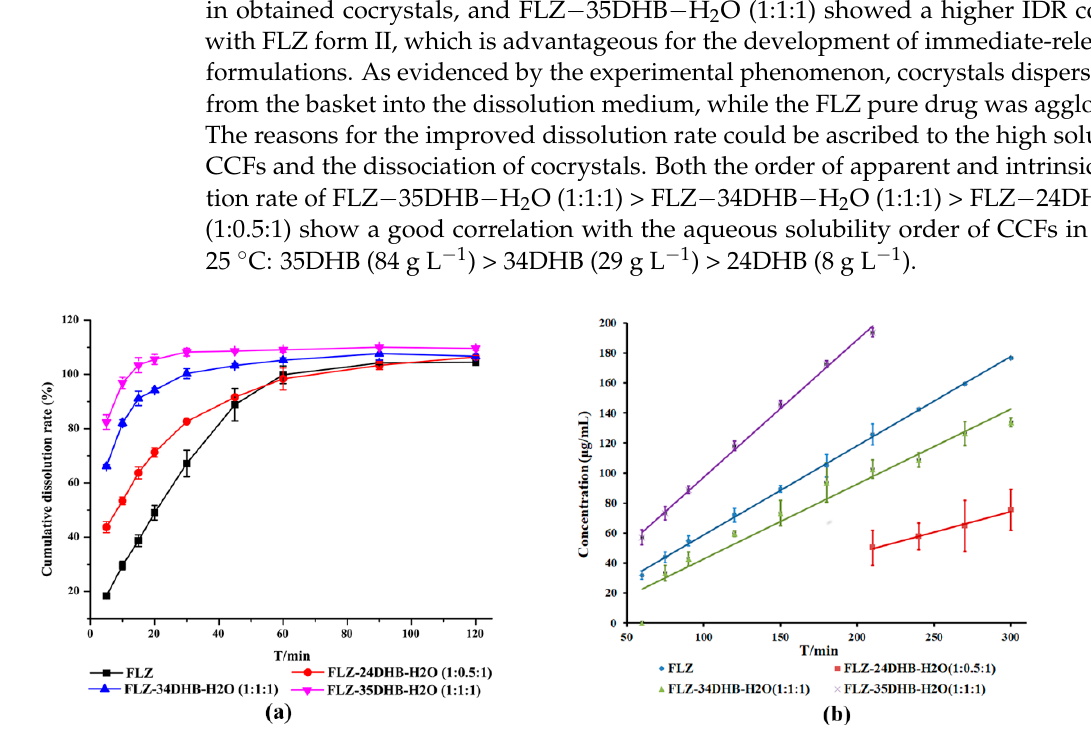
Figure 11. ( a ) Powder dissolution studies, ( b ) intrinsic dissolution rates of marketed FLZ form II and its cocrystal hydrates in ultrapure